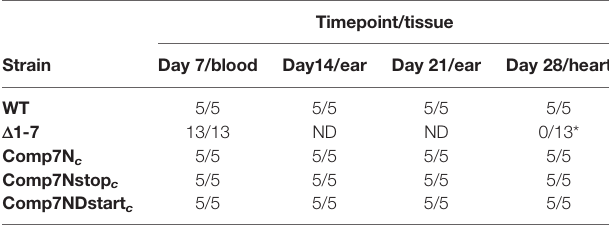
TABLE 2 | Heart colonization by non-native bbd07 complement strains.